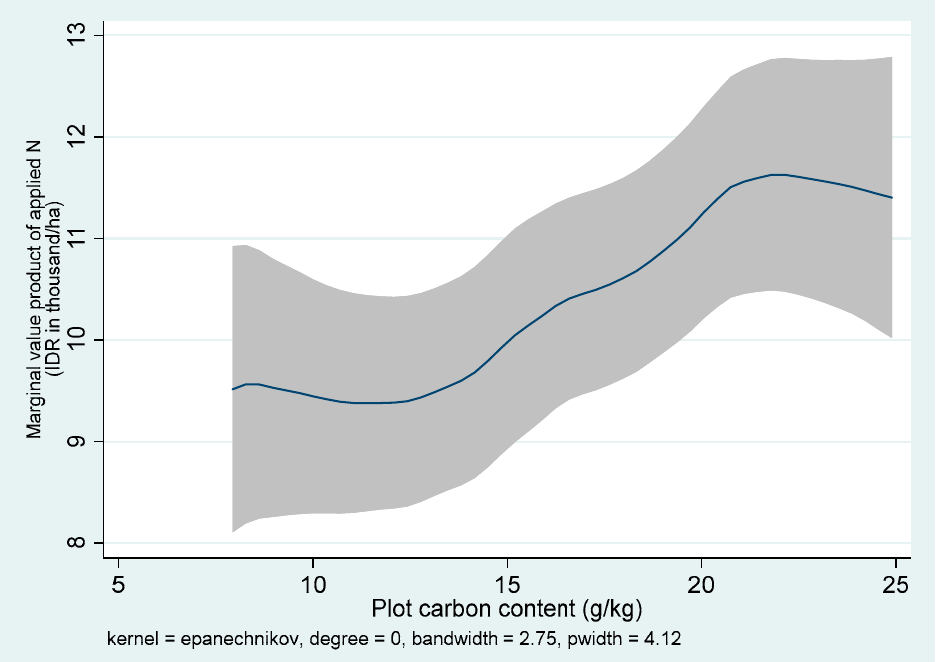
Figure 10. Marginal value product of nitrogen applied based on the plot’s carbon content in Sukamand, Indonesia.